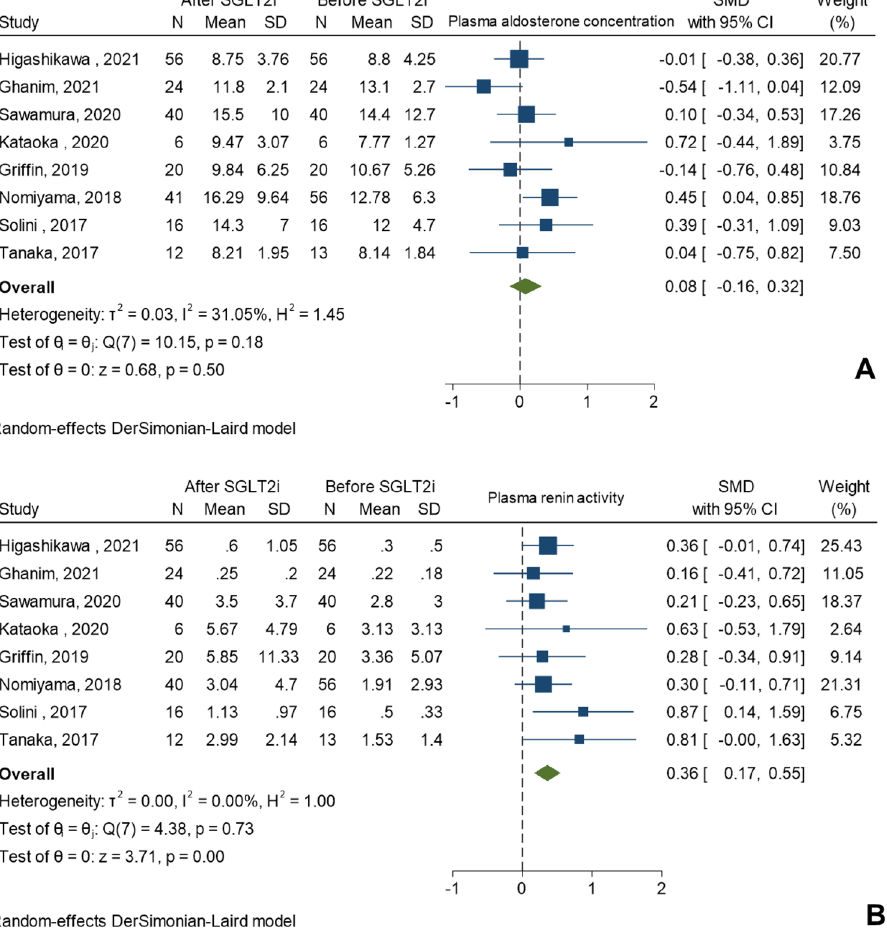
Figure 3. Forest plots of changes in ( A ) plasma aldosterone concentration and ( B ) plasma renin activity after the use of SGLT2i in non-randomized controlled studies.